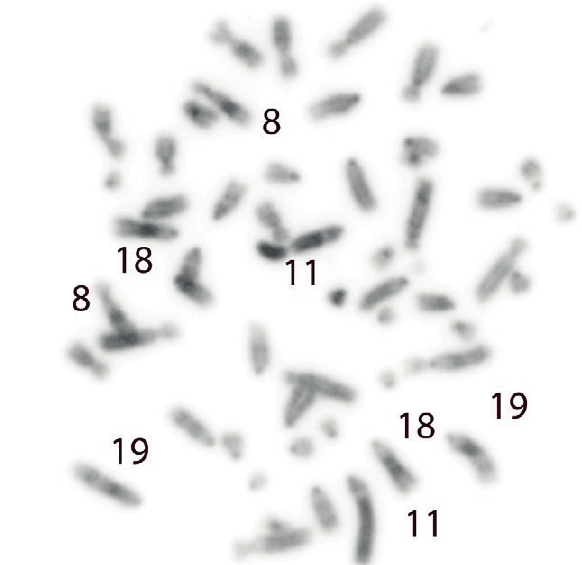
Figure 3. Metaphases of S. cay paraguay with C bands. Example of representative chromosome pairs with evident bands are indicated with